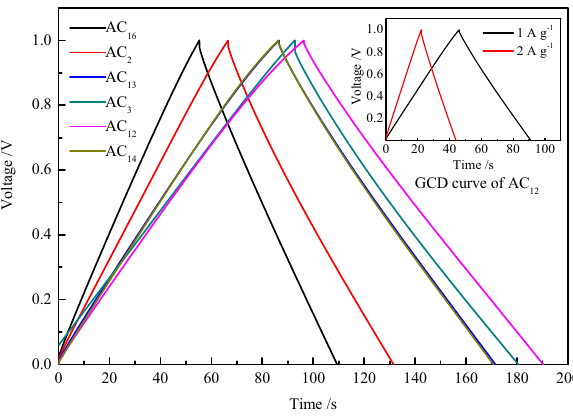
Figure 9. GCD curves of SACs at the current density of 0.5 A g −1 .